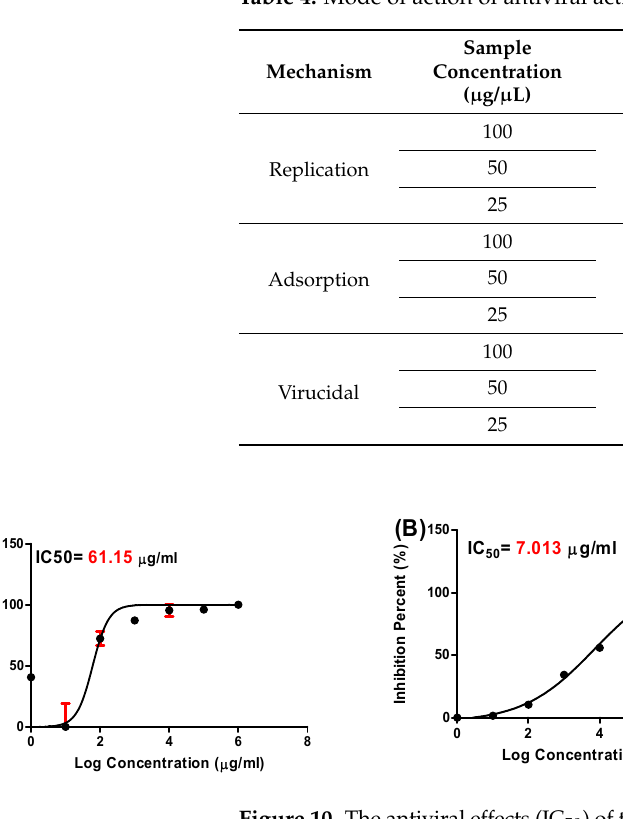
Table 4. Mode of action of antiviral activity.